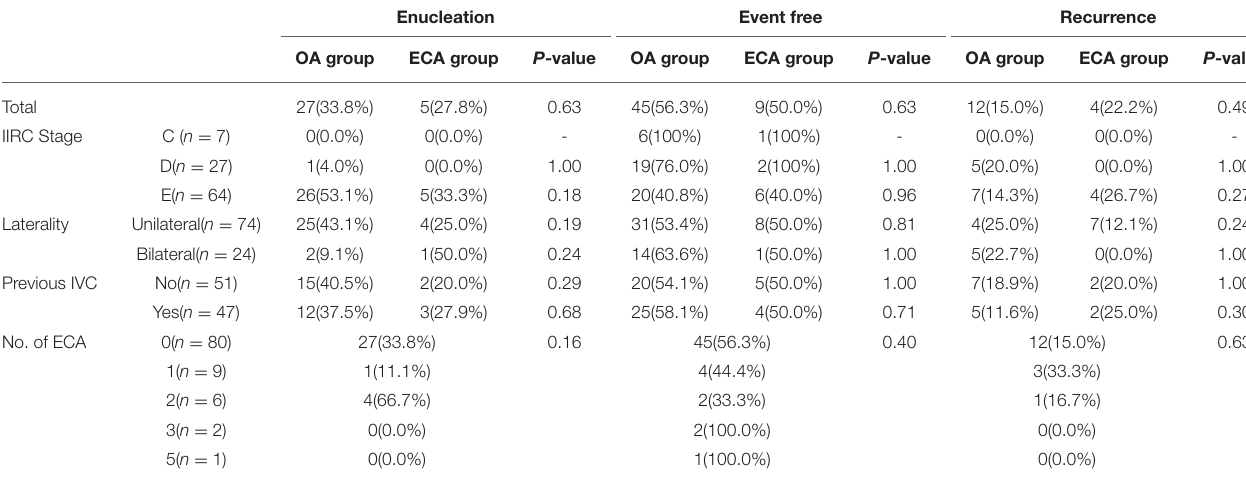
TABLE 2 | The outcomes of 98 eyes receiving IAC.